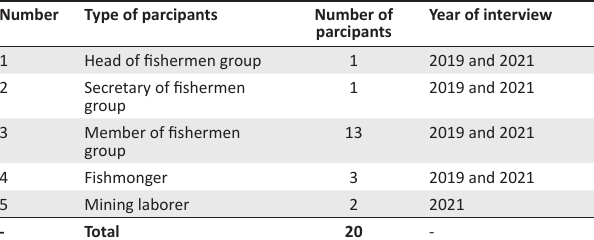
TABLE 1: Number and type of